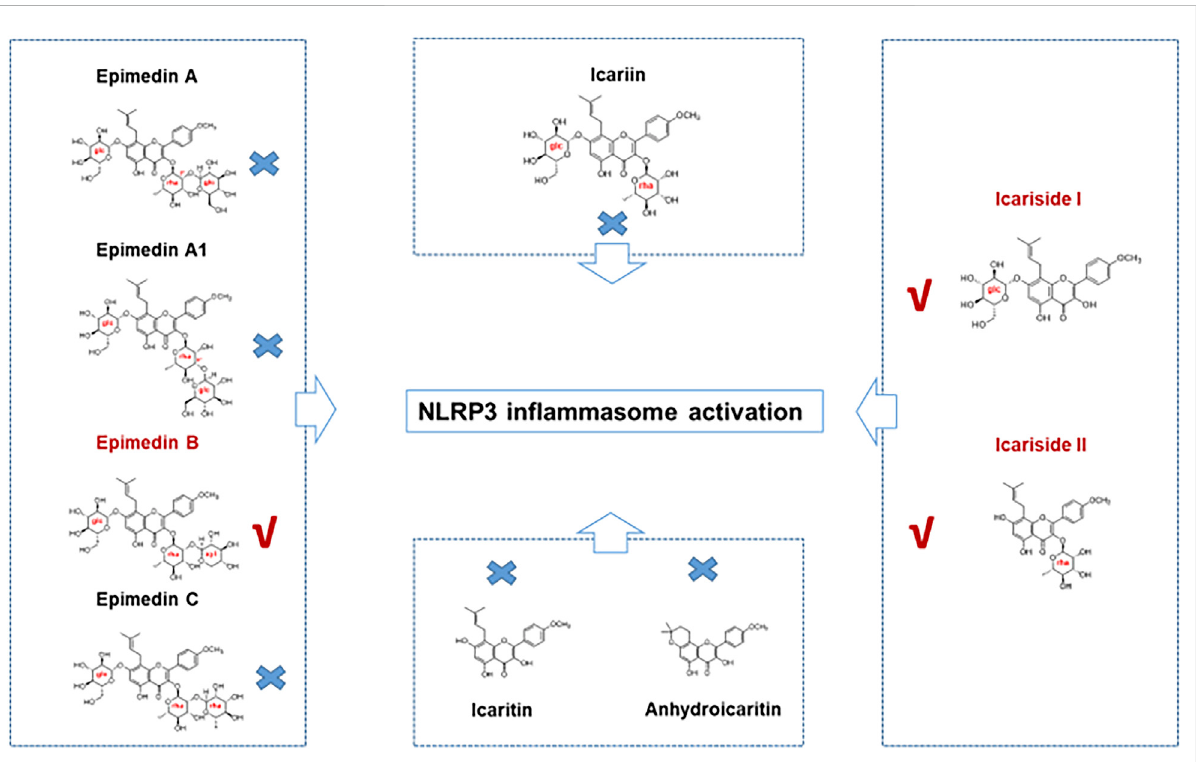
FIGURE 2 The relationship between the chemical structure and NLRP3 in fl ammasome activity of the main active constituents of Epimedii folium. Epimedin B, Icariside I, and Icariside II could promote NLRP3 in fl ammasome activation. Six other major active constituents of Epimedii folium